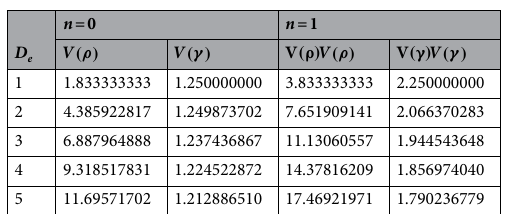
Table 4. Variance in position space and momentum space for the ground state and the first excited state with µ = (cid:31) = C = ℓ = (cid:31) = r e = 1 for five different values of D